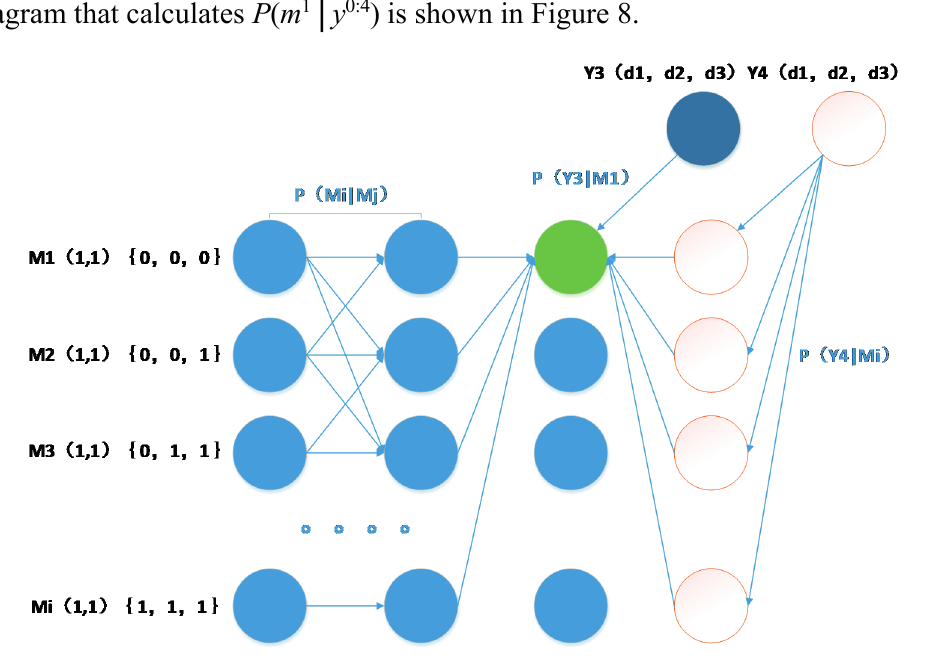
Figure 8. Flow diagram of the M-HMM